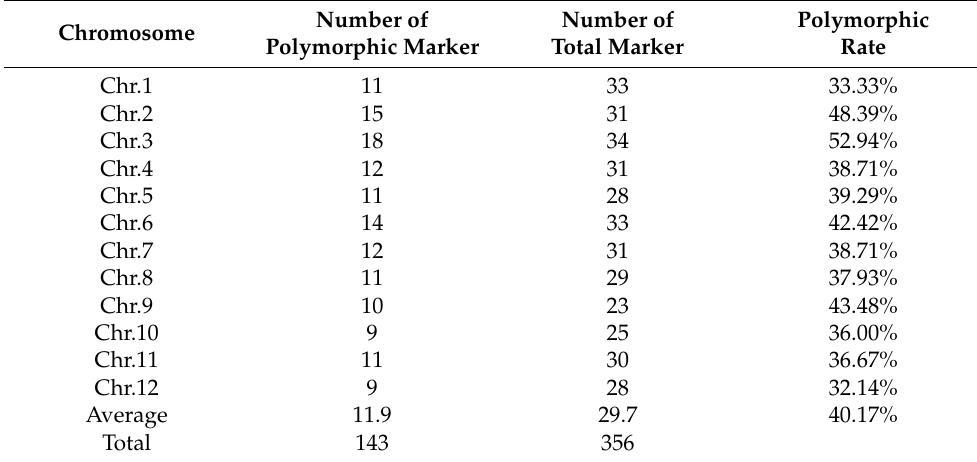
Table 1. Distribution of polymorphic markers on the 12